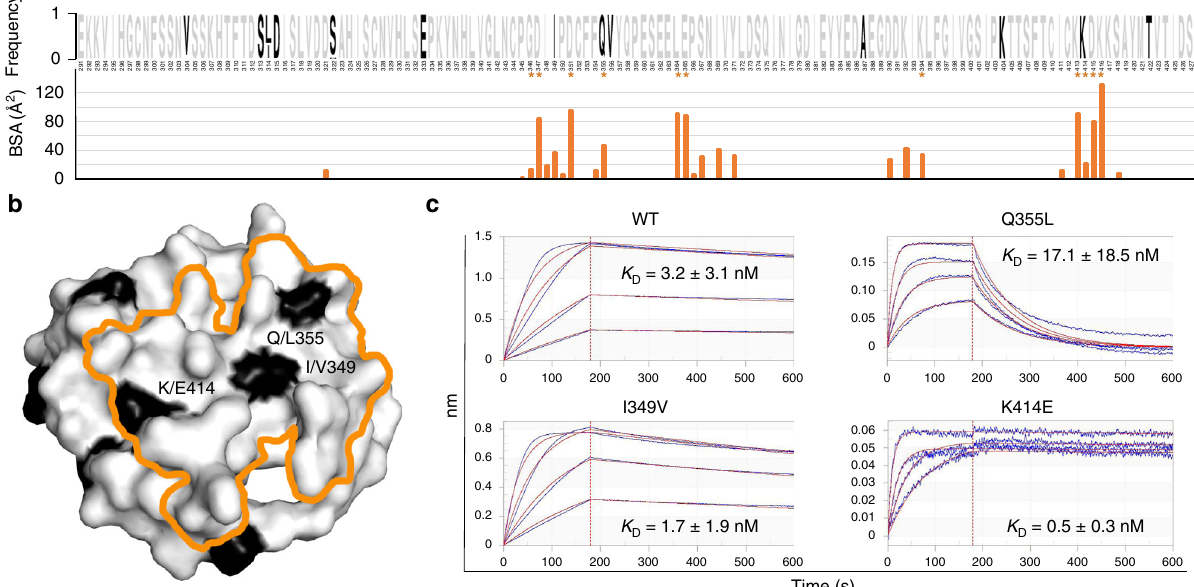
Fig. 4 Pfs48/45 sequence polymorphisms in the 85RF45.1 epitope. a Weblogo 58 representation of sequence variability in Pfs48/45 6C. Sequences were compiled from the NCBI, PlasmoDB, and Uniprot databases. Invariant and polymorphic residues are colored gray and black, respectively. The buried surface area of each Pfs48/45 residue contacted by mAb 85RF45.1 as determined by PISA 59 is shown below. An asterisk denotes a Pfs48/45 residue that forms an H-bond or salt bridge with mAb 85RF45.1. b Polymorphism mapped onto the Pfs48/45 surface colored according to a . The 85RF45.1 epitope is outlined in orange. c Binding af fi nity of 85RF45.1 Fab to Pfs48/45 6C constructs with point mutations representative of sequence polymorphisms in the 85RF45.1 epitope. Blue lines are representative of raw data, whereas red curves represent global fi tting. The different sensograms correspond to Fab concentrations of 250, 125, 62.5, and 31.3 nM. K D ’ s are indicated with standard deviation and derive from at least two independent (fused to human IgG1 constant regions) antibodies were cloned into LakePharma ’ s high expression mammalian vector system and transient production was per- formed in HEK293 cells (Thermo Fisher Scienti fi c). Starting at 20h, and throughout the transient transfection production, antibody titers were measured (Octet QKe, ForteBio). Cultures were harvested at day 5 and antibodies in the conditioned media were puri fi ed using MabSelect SuRe Protein A resin (GE Healthcare) for validation.